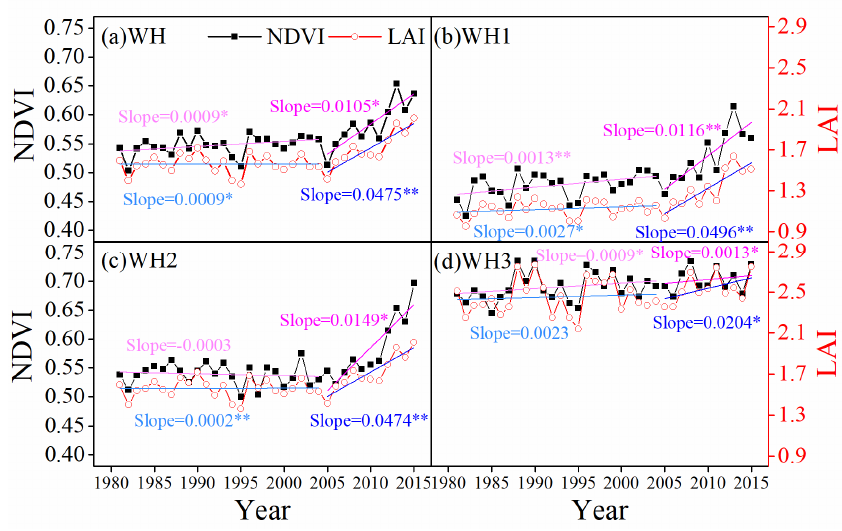
Figure 6. Annual mean satellite-estimated normalized difference vegetation index (NDVI) and leaf